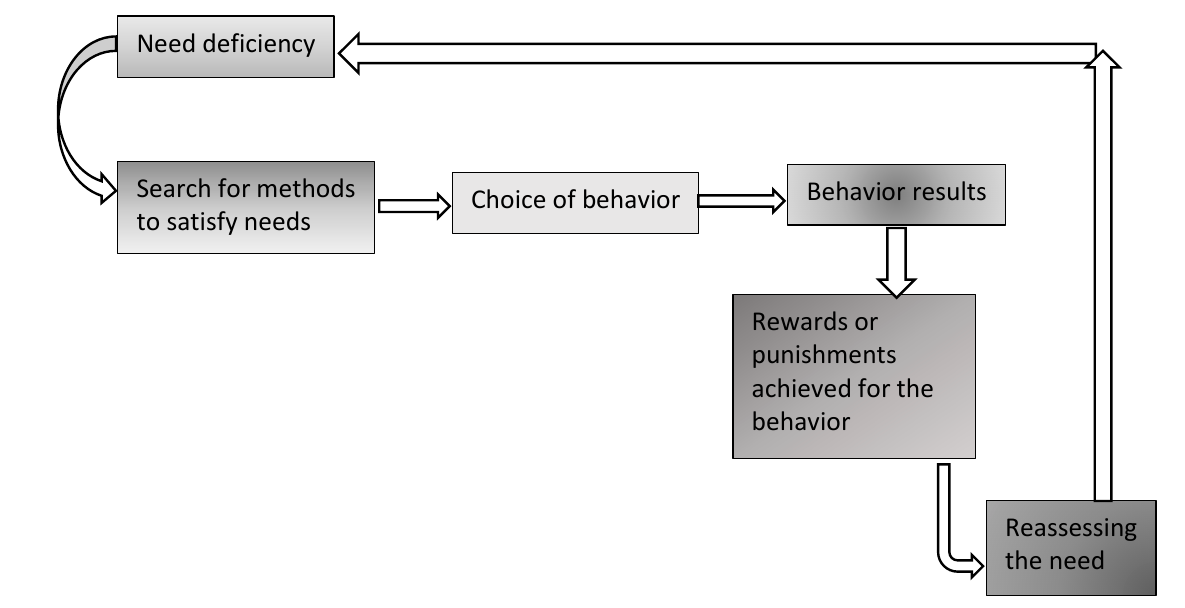
Figure 1. Motivation is a circle, a process without an end (based on: Griffin and Moorhead 2014, p. 91).